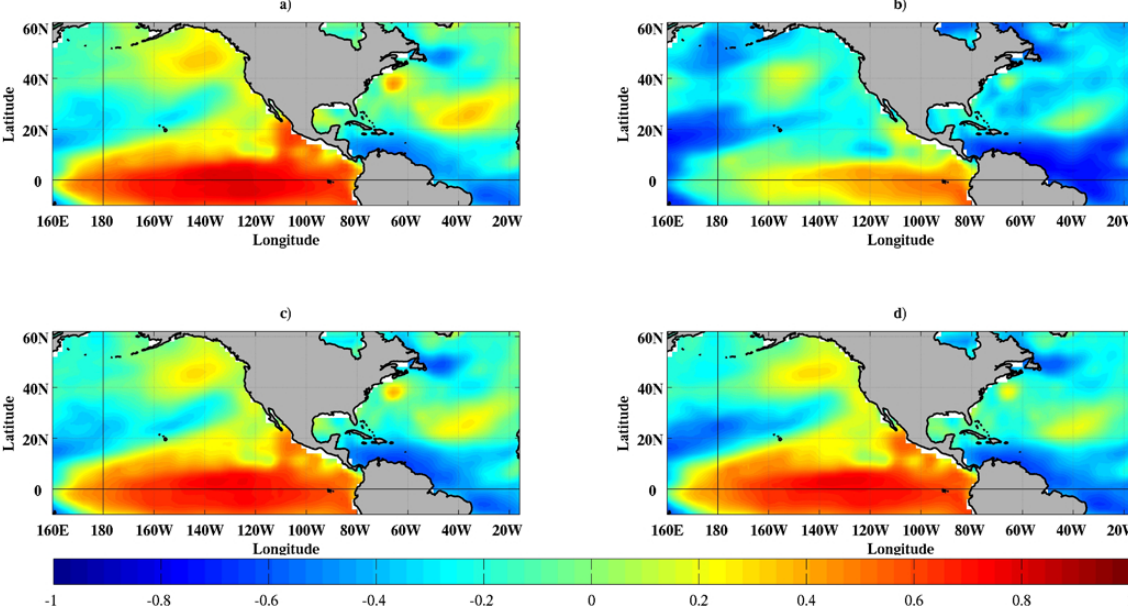
Fig. 4. July SST spatial loadings (mode 1) of each model: (a) ACM, (b) FRD, (c) p80 and (d) p10.